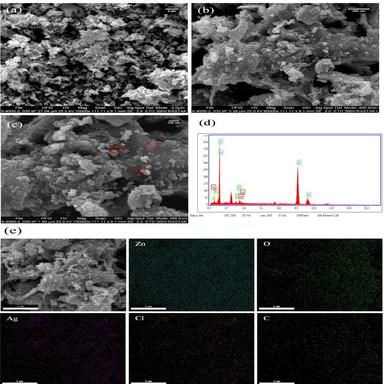
SEM micrographs (a–c), EDX spectrum (d), and elemental mapping (e) of Ag/AgCl--ZnO.